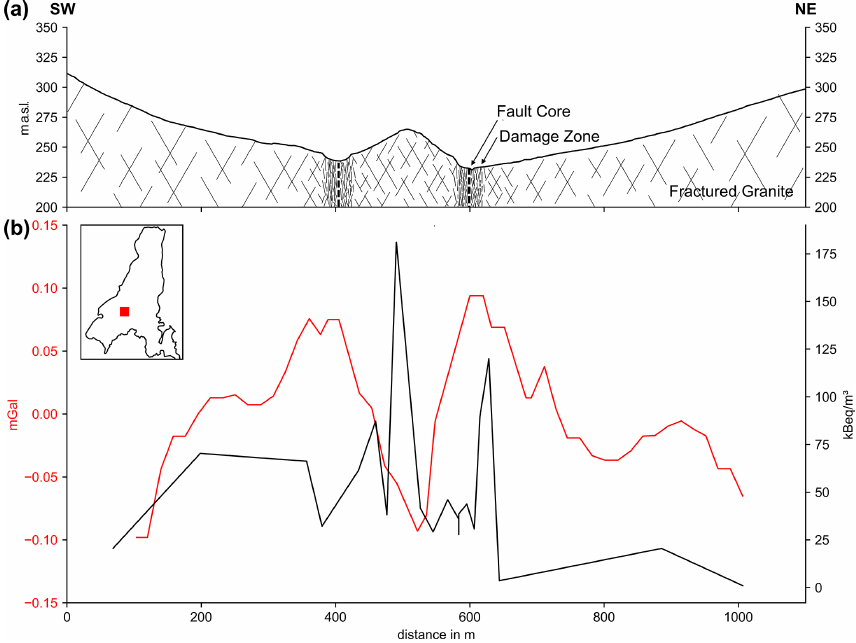
Figure 11. (a) Schematic cross-section of the investigated profile; (b) comparison of the high-pass-filtered Bouguer anomalies (red line) and the measured radon concentration in the soil air (black line). The small map shows the location of the profile within the Tromm Granite (see also Fig.